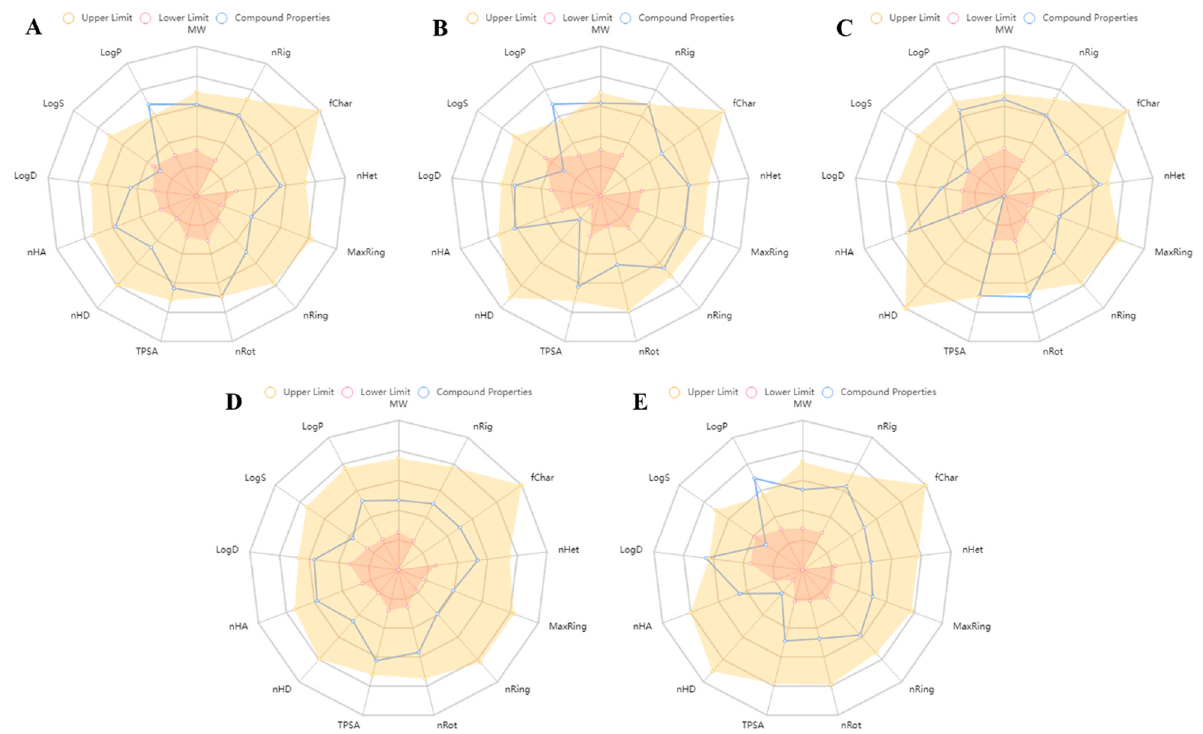
Figure 9. A radar plot of physiochemical properties of selected virtual hits ( A ) AKS-01, ( B ) AKS-02, ( C ) AKS-03, ( D ) AKS-04, and ( E ) AKS-05 predicted by ADMETlab. Table 3. In silico predicted physiochemical, pharmacokinetic, toxicity, and cross-reactivities of the five selected virtual hits.